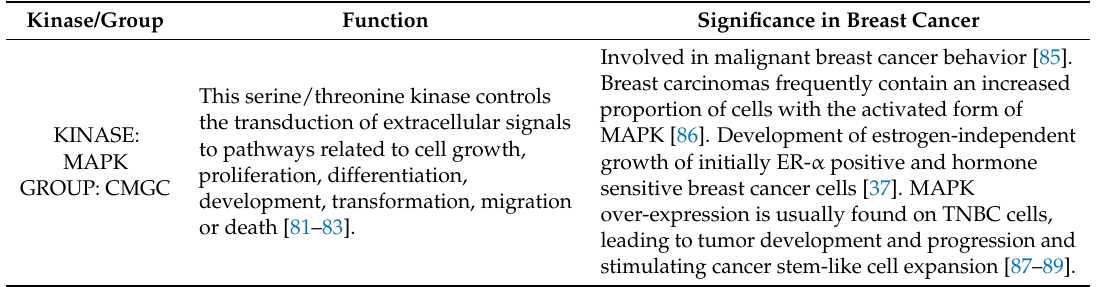
Table 7. Mitogen-Activated Protein Kinase Pathway (MAPK) alterations and significance in breast cancer. Kinase/Group